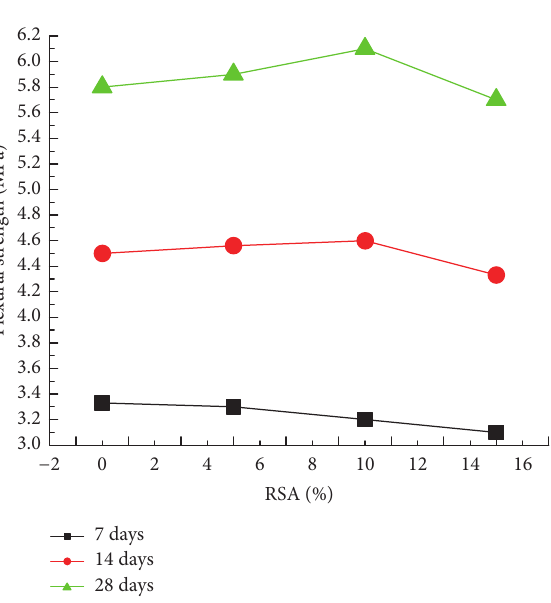
Figure 8: Variations of compressive strength.